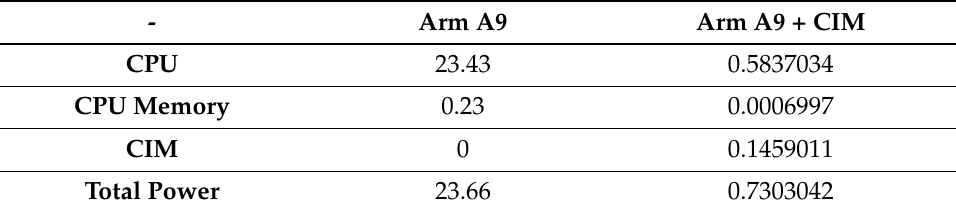
Figure 17. ( a ) CPU, ( b ) memory, and ( c ) overall. Table 5. Comparison of non-CIM architecture and CIM